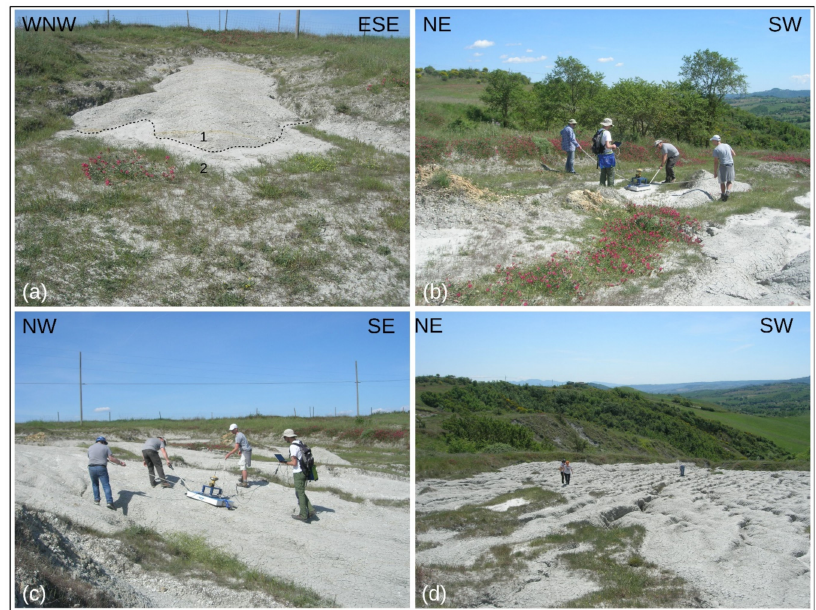
Figure 4. Pictures of the survey area, with detail of the different sectors surveyed of Figure 1; ( a ) alternation of compacted marine clay (1), thin unconsolidated sedimentary cover resulting from weathering processes and grass at surface (2); ( b ) GPR profile acquisition in a sector alternating compact clayey beds, weathering fine deposits, grass, and cololites outcropping at the surface; ( c ) compact clays with visible mud cracks and irregular topographic surface; ( d ) area with dense and deep channels generated by gully erosion where it was not possible to pull the GPR